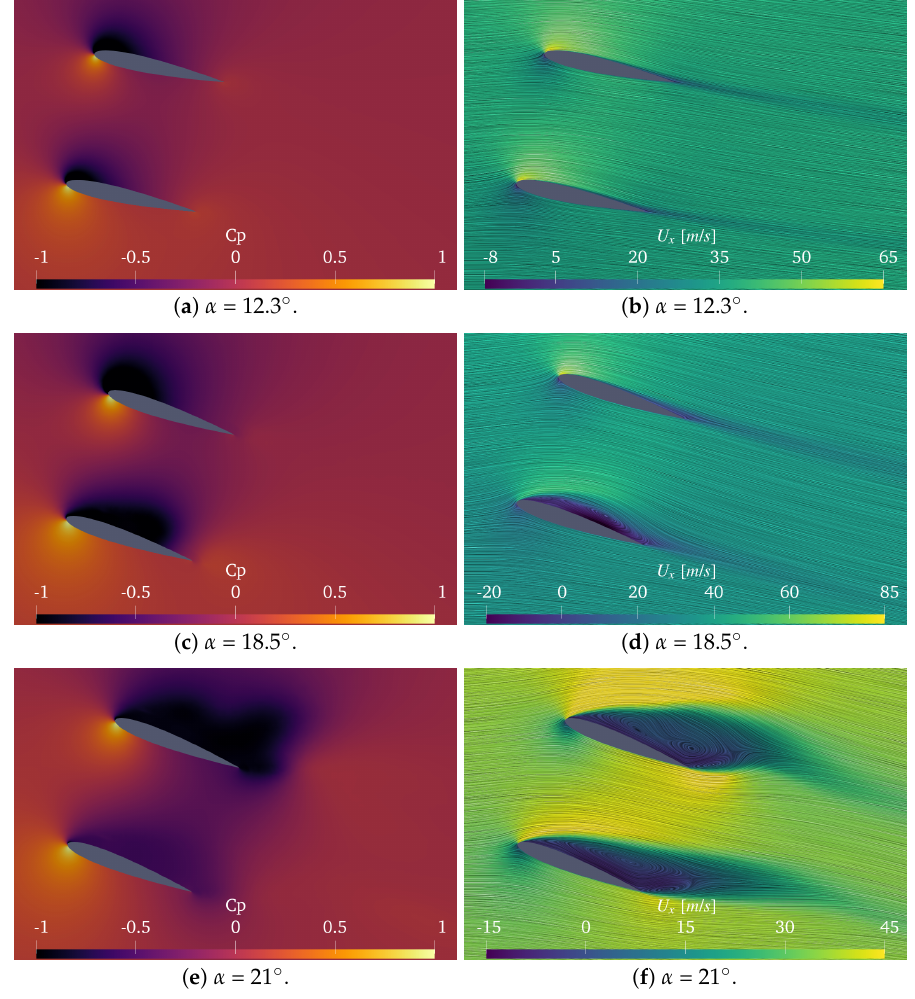
Figure 13. Midsection: C p ( left ) and U x ( right ) contours at different angles of attack (note that colours match different values for each α )